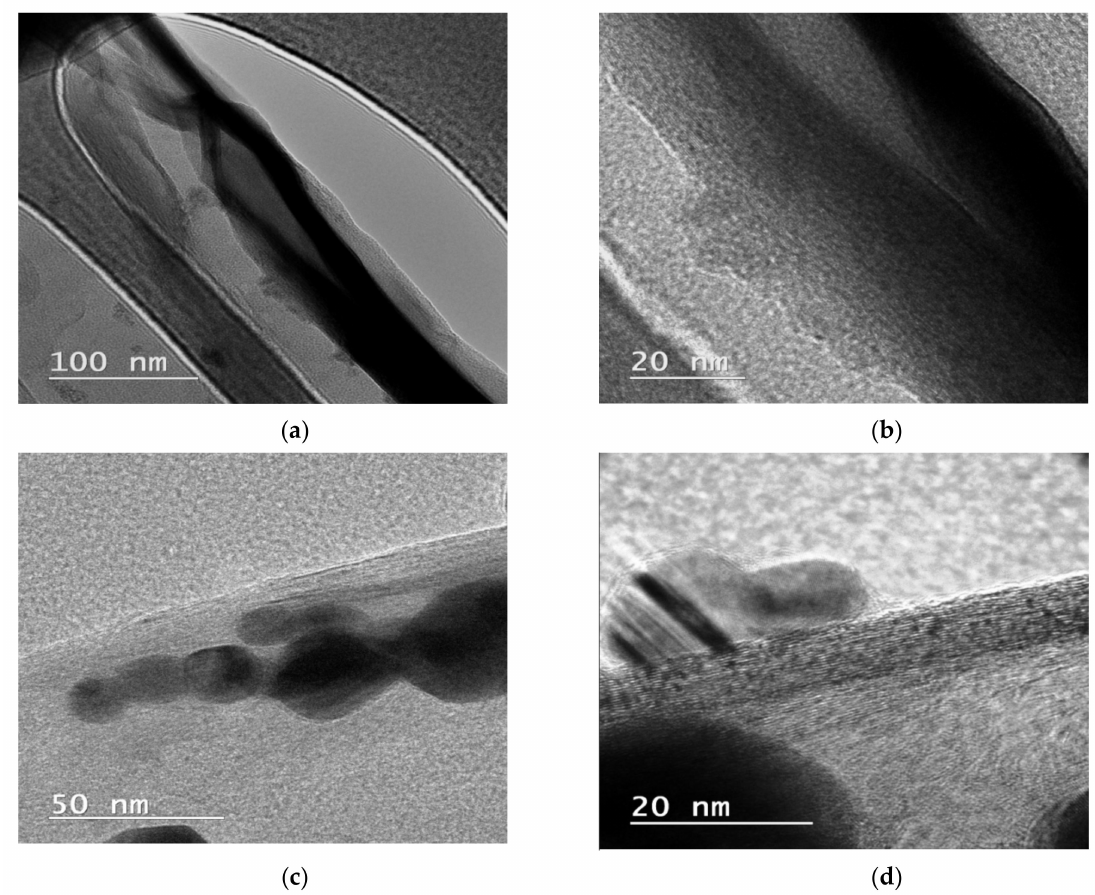
Figure 6. TEM micrographs of the MWCNTs_ZnO ( a , b ) and MWCNTs_Ag ( c , d